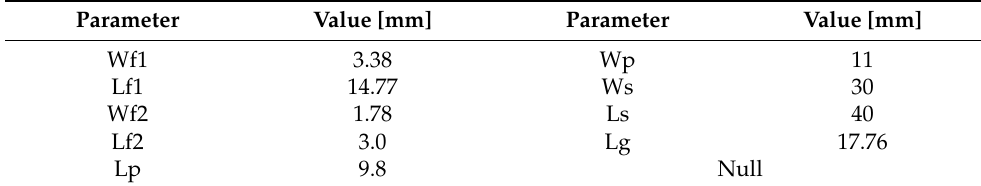
Table 1. Optimized parameters of the modified UWB